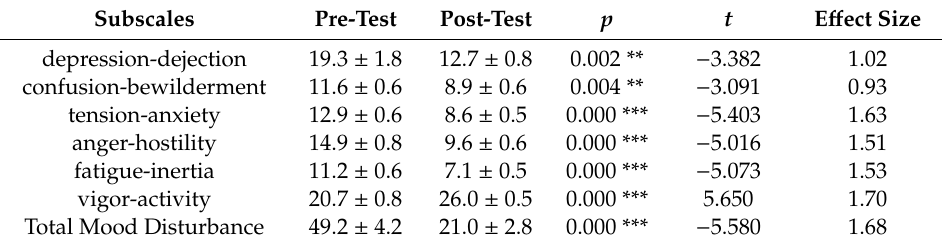
Table 10. E ff ect of Herb Tasting and Smelling on Profile of Mood State